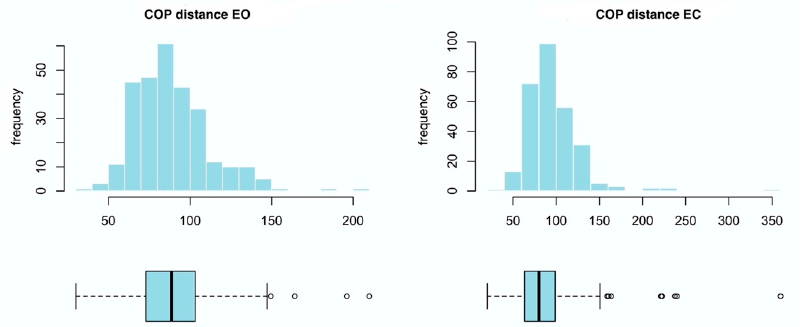
Figure 3. Box plots and histograms for the two-dimensional COP distance variable. The graphs were constructed from all the data gathered from both groups. COP—center of pressure; EO—eyes open; EC—eyes closed.